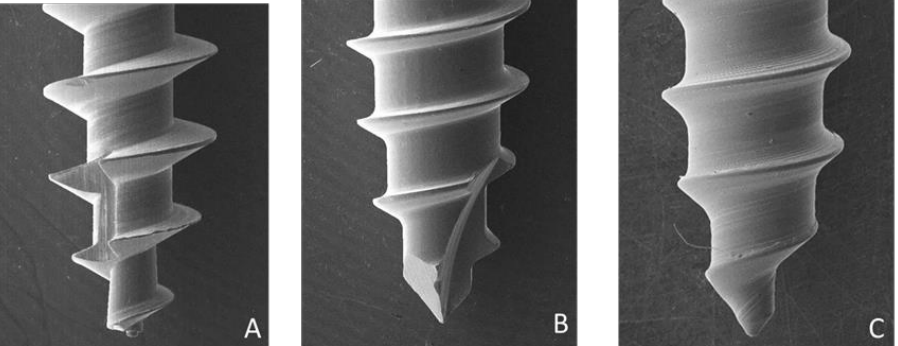
Figure 4. Thread in the apical portions of microimplants were magnified by a scanning electron microscope (Hitachi SU8010, Japan). From left to right: Type ( A ) (no microthread neck), Type ( B ) (no microthread neck), and Type ( C ) (microthread neck).